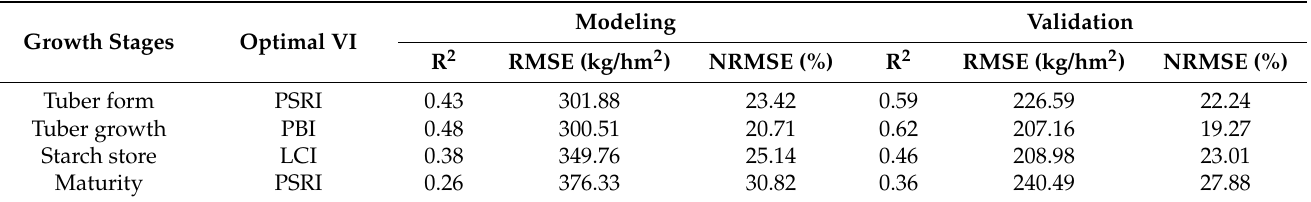
Table 4. Linear regression relationship between optimal VIs and AGB of potato for the four growth stages.